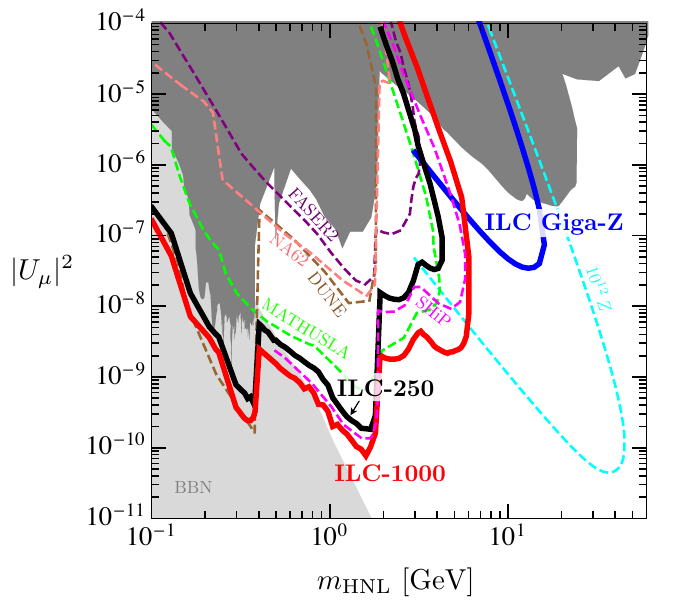
Figure 7 . Sensitivity reach of ILC beam dump experiment to HNLs mixing with the mu-neutrino in the mass and mixing plane. For the description of this plot, see the caption of figure 5.